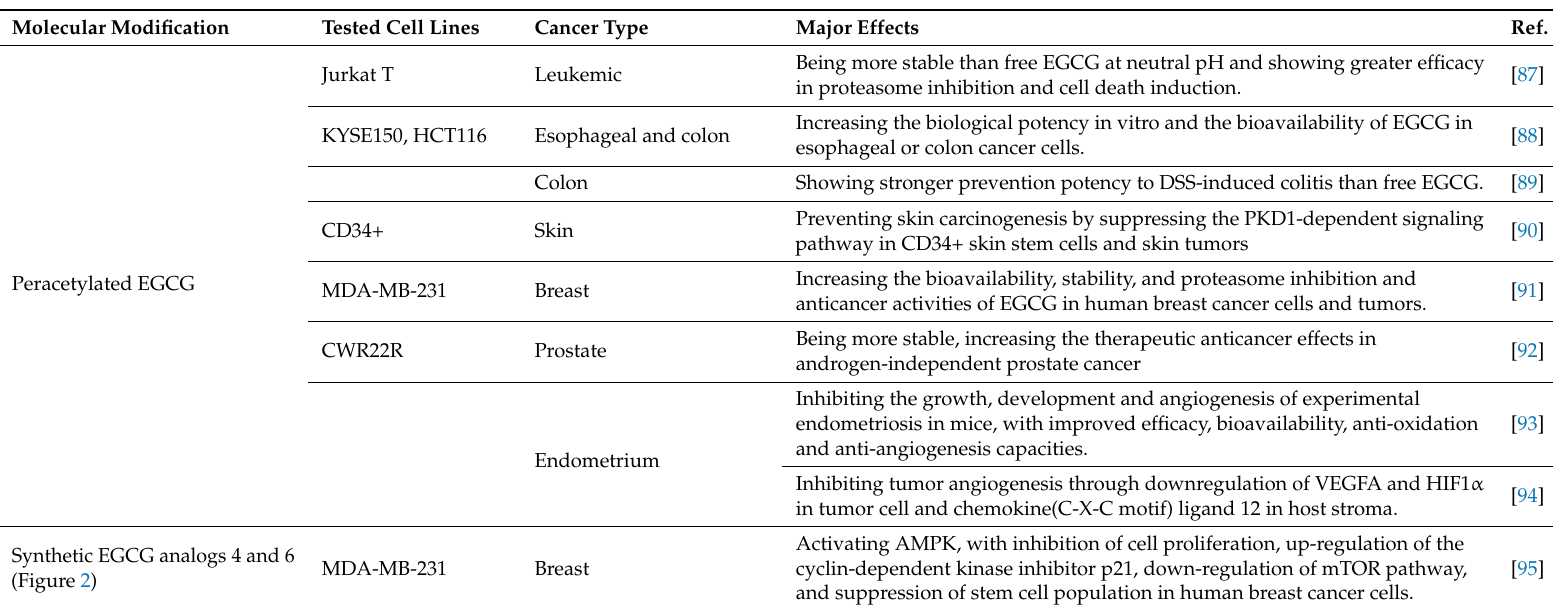
Table 2. Molecular modification of EGCG and its